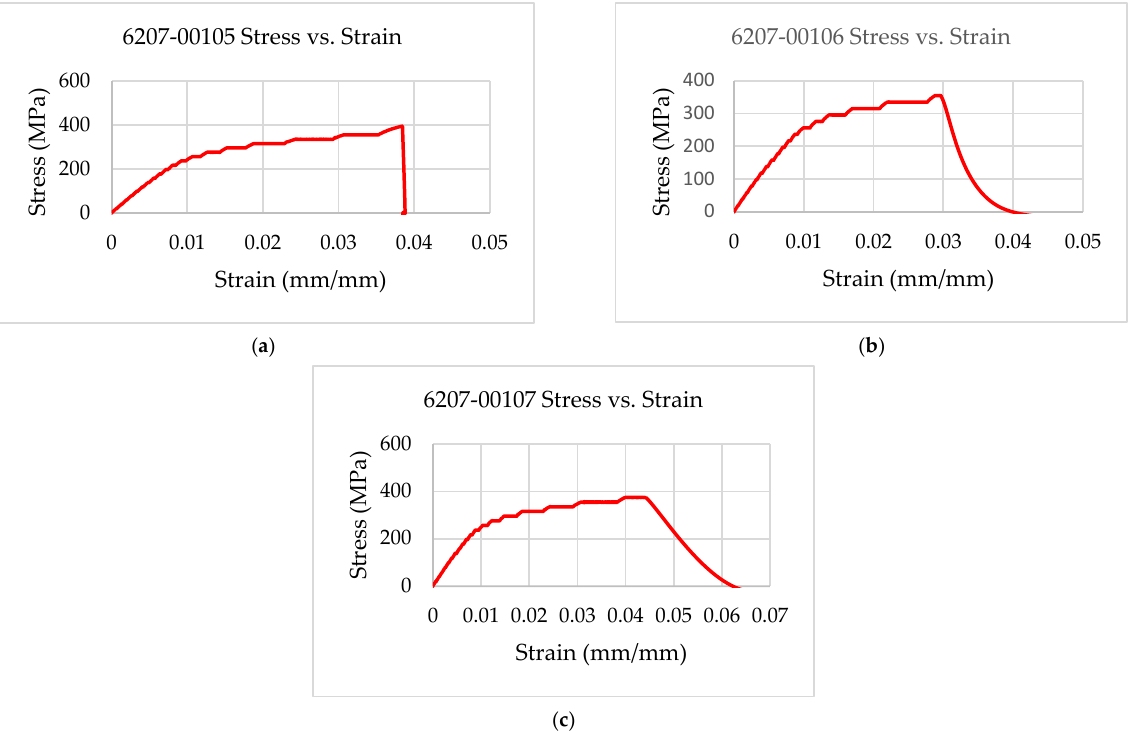
Figure 8. Strain-strain characteristics of multifunctional test specimens: ( a ) 6207-00105; ( b ) 6207-00106; ( c ) 6207-00107.